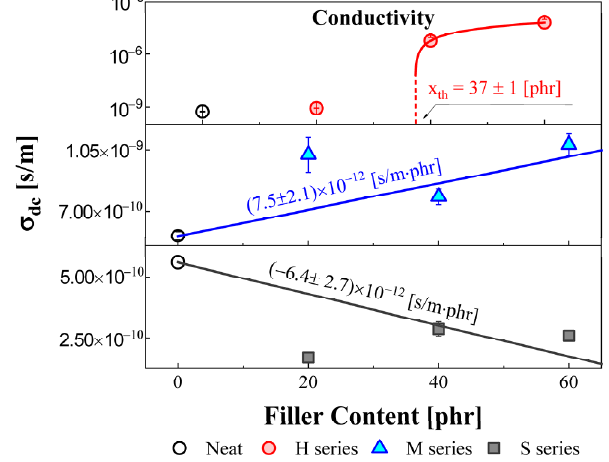
Figure 5. Conductivity for NBRs with different filler types and contents at 298 K. The red circle indicates the H series, and the blue triangle and gray square symbols indicate the M and S series, respectively. The red solid line indicates the fitting result of Equation (8).